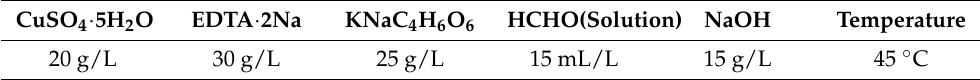
Table 2. Technology conditions of electroless copper coating.